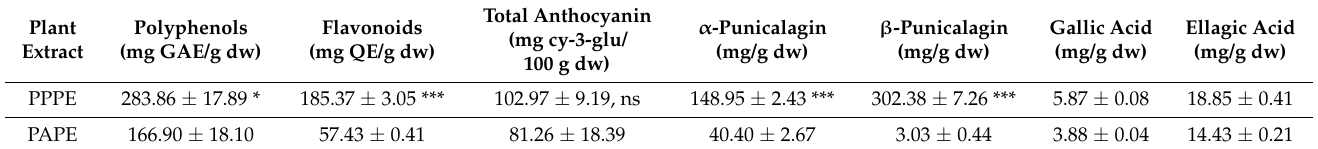
Table 1. Total phenolic, flavonoid, and anthocyanin content of PPPE and PAPE. Results are expressed as the mean ± sem of at least three independent assays of each sample. * p < 0.05 and *** p < 0.001 indicate significant differences compared to the control. ns: not